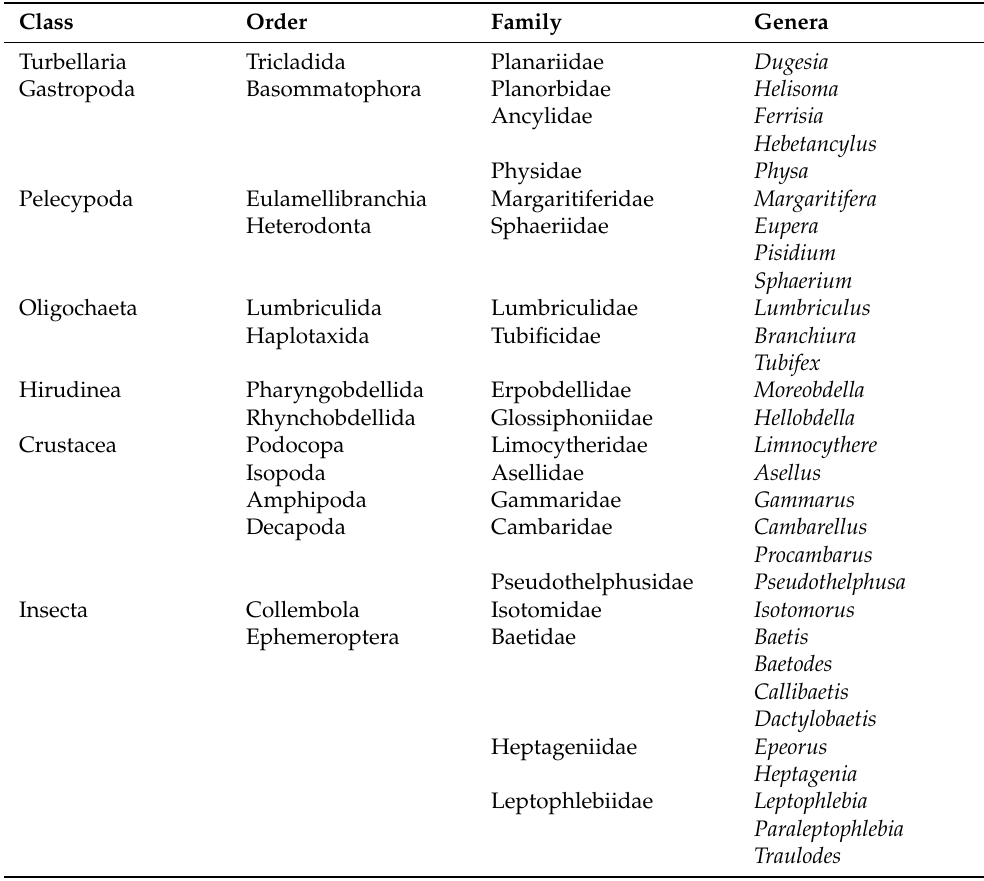
Table A1. Taxonomic list of the macroinvertebrate found in the Duero river. Asterisks indicate the families not found in the year